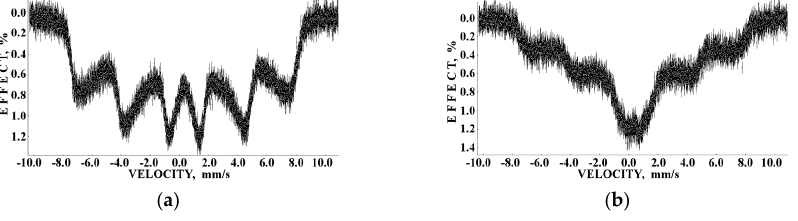
Figure 43. Mössbauer spectra of the FM ( a ) and FMC ( b ) nanoparticles measured at 295 K in 4096 channels. Adapted from Ref. [76] with permission from Springer Nature: Hyperfine Interactions, “Effect of iron oxide nanoparticles functionalization by citrate analyzed using Mössbauer spectroscopy”, Ushakov M.V., Sousa M.H., Morais P.C., Kuzmann E., Semionkin V.A., Oshtrakh M.I., ©2020.